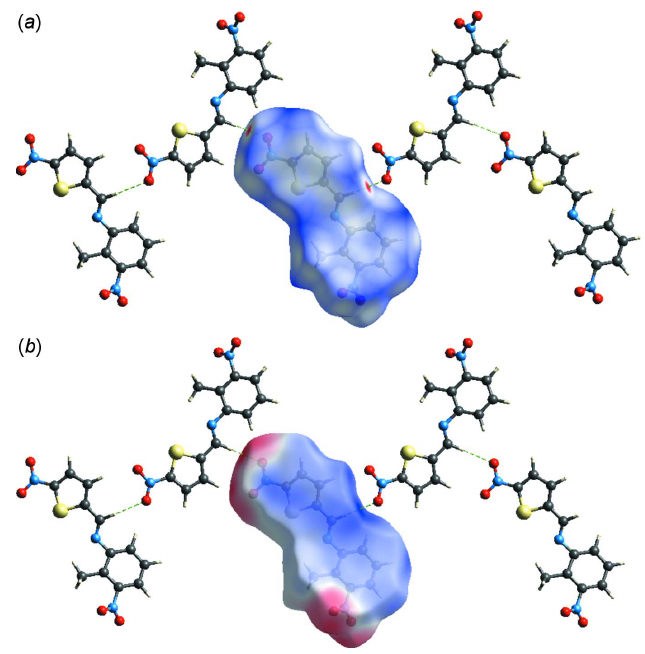
Figure 3 Hirshfeld surfaces of the title compound mapped over ( a ) d norm and ( b ) electrostatic